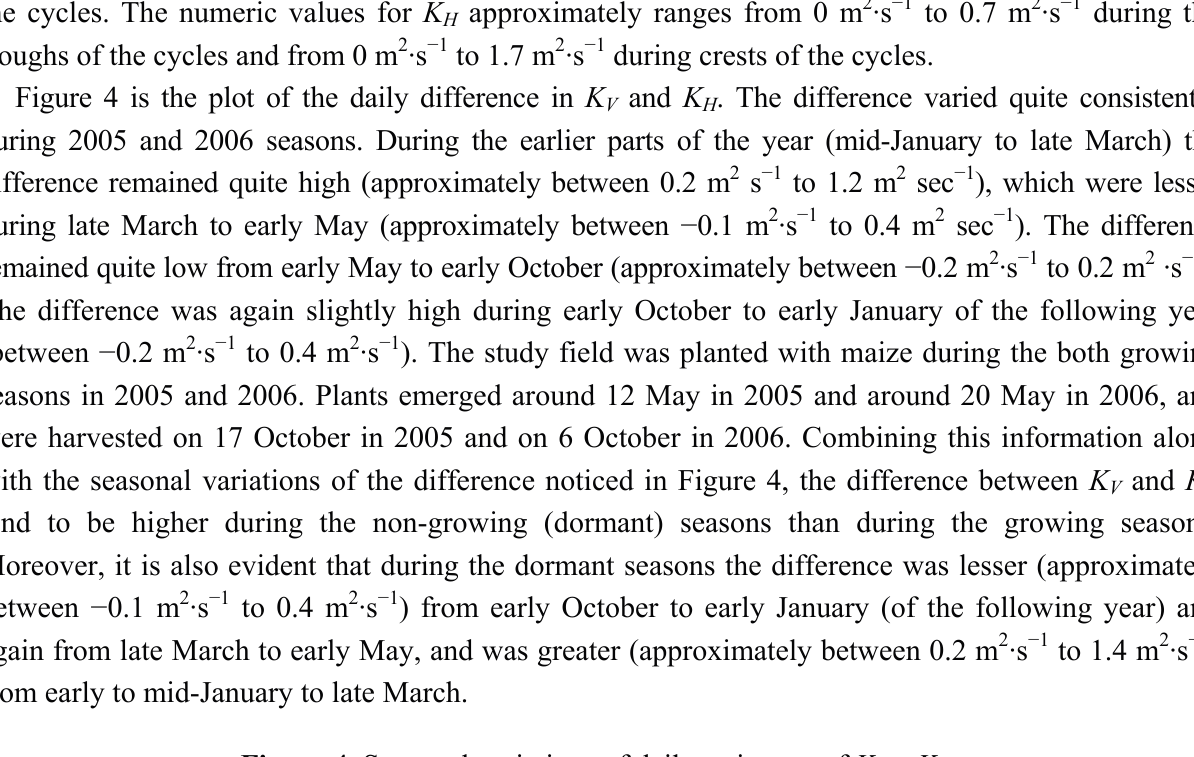
Figure 4. Seasonal variations of daily estimates of K